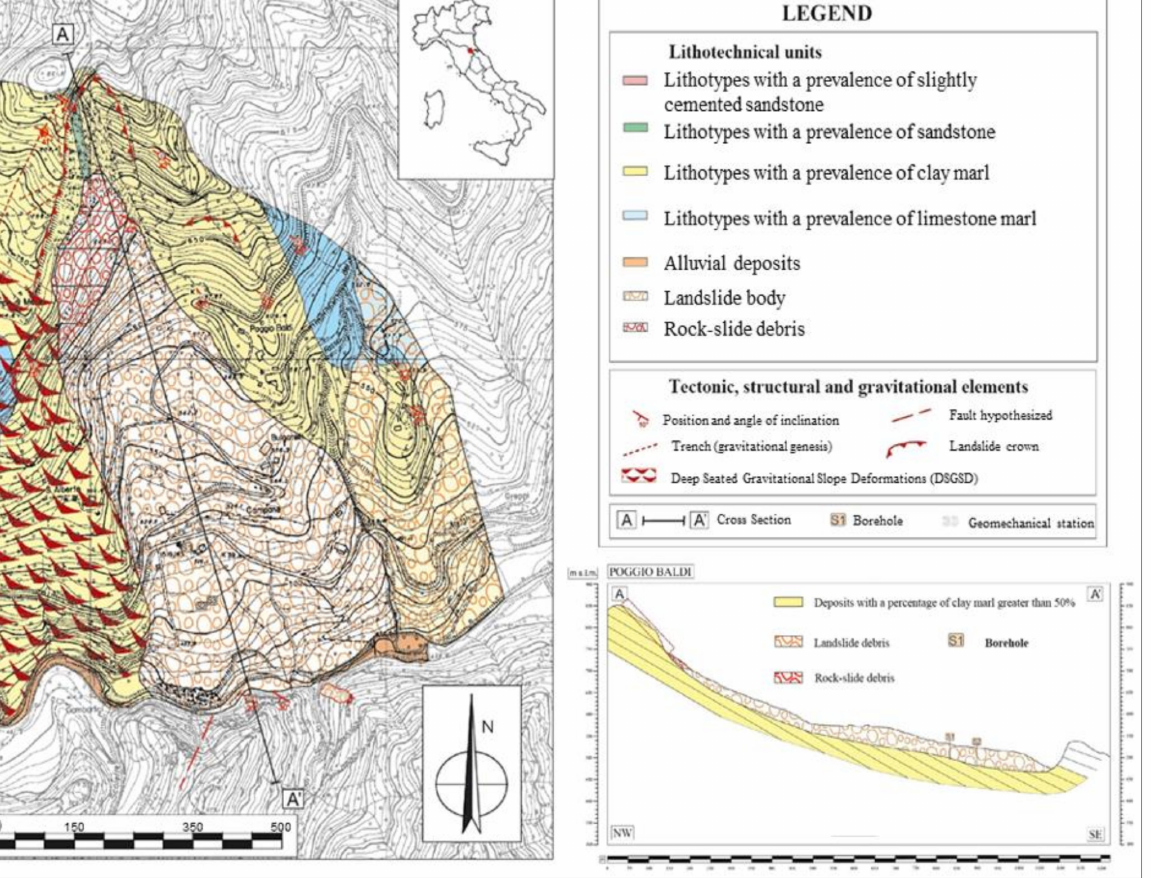
Figure 5. Geological map of the Poggio Baldi landslide area with a related cross-section along its body. The investigated rockfalls arise from the rock cliff outlined by the red dashed line and by the red box in the cross-section; modified from